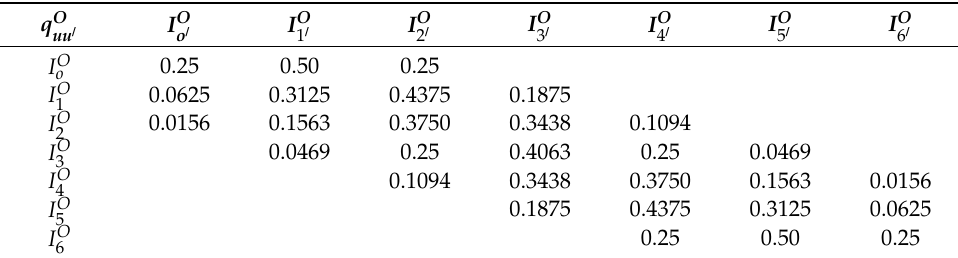
of all possible transitions in Nb–50V uu /